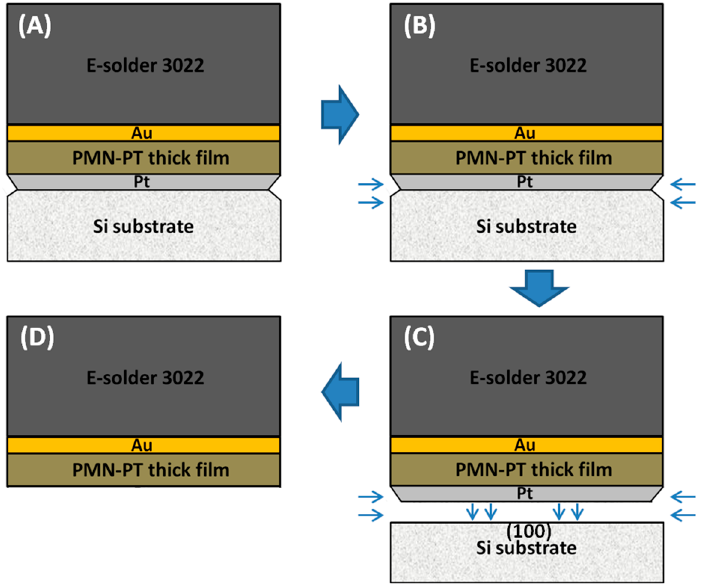
Figure 3. The schematic diagram of PMN-PT thick film transfer process: ( A ) after dicing; ( B ) etching; ( C ) after etching; ( D ) after transfer.